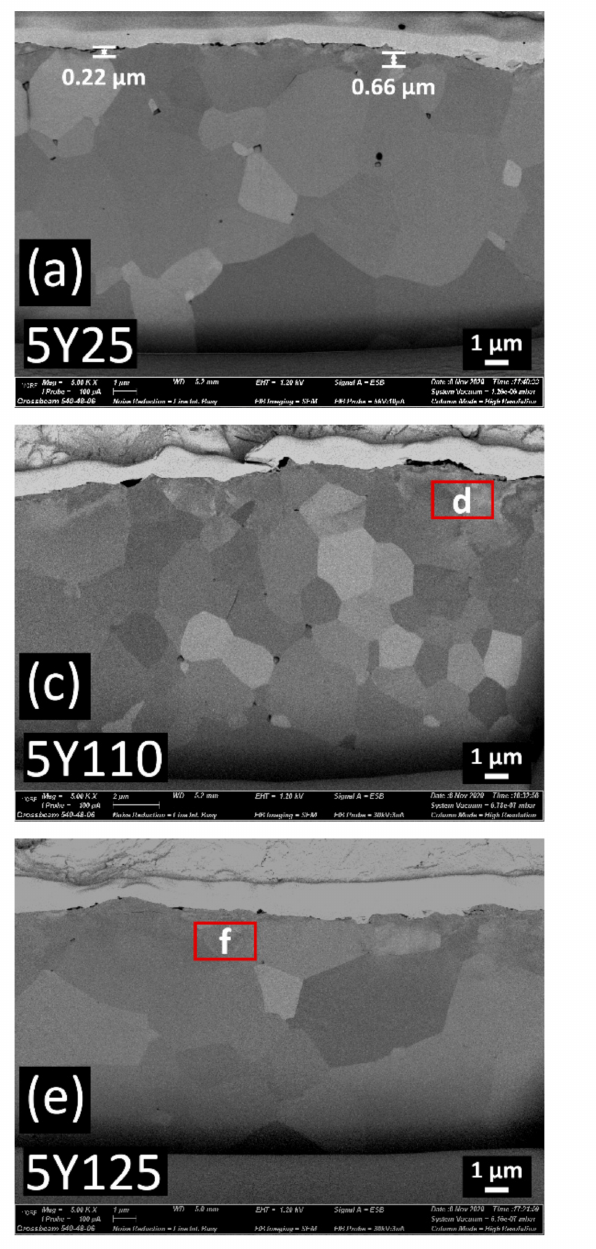
Figure 9. FIB cross-sections of ( a ) 5Y25, ( b ) 5Y90, ( c ) 5Y110; the thin box indicates the location of detail ( d ), ( d ) detail of the deformed zone of 5Y110, ( e ) 5Y125; the thin box indicates the location of detail ( f ), ( f ) detail of the deformed zone of 5Y125. Thin transformed layer is found below 0.7 µ m under the surface in 5Y25, while lateral crack is connected to the surface without isolated transformed grain zone in 5Y90. Alumina particle debris (shown in orange arrows) was detected in 5Y90. In detail ( d ) and detail ( f ), homogeneous deformed zones with plastic deformation and surface melting are found. Abnormal grain growth is observed in